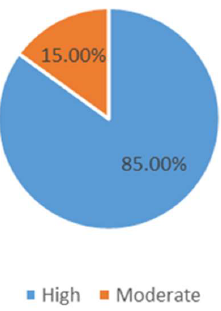
Figure 1. Distribution of study population according to caries risk assessment.